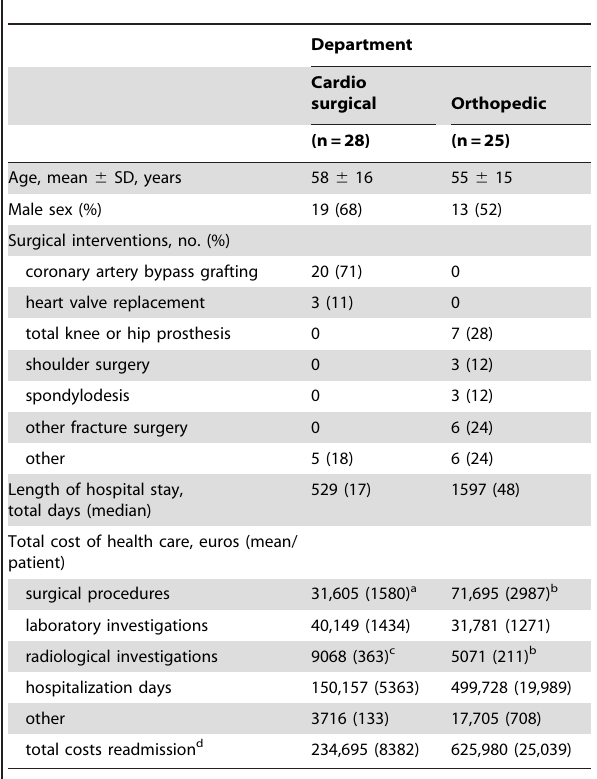
Table 1. Direct health care costs of patients readmitted because of a postoperative surgical site infection between 2001 and 2010.